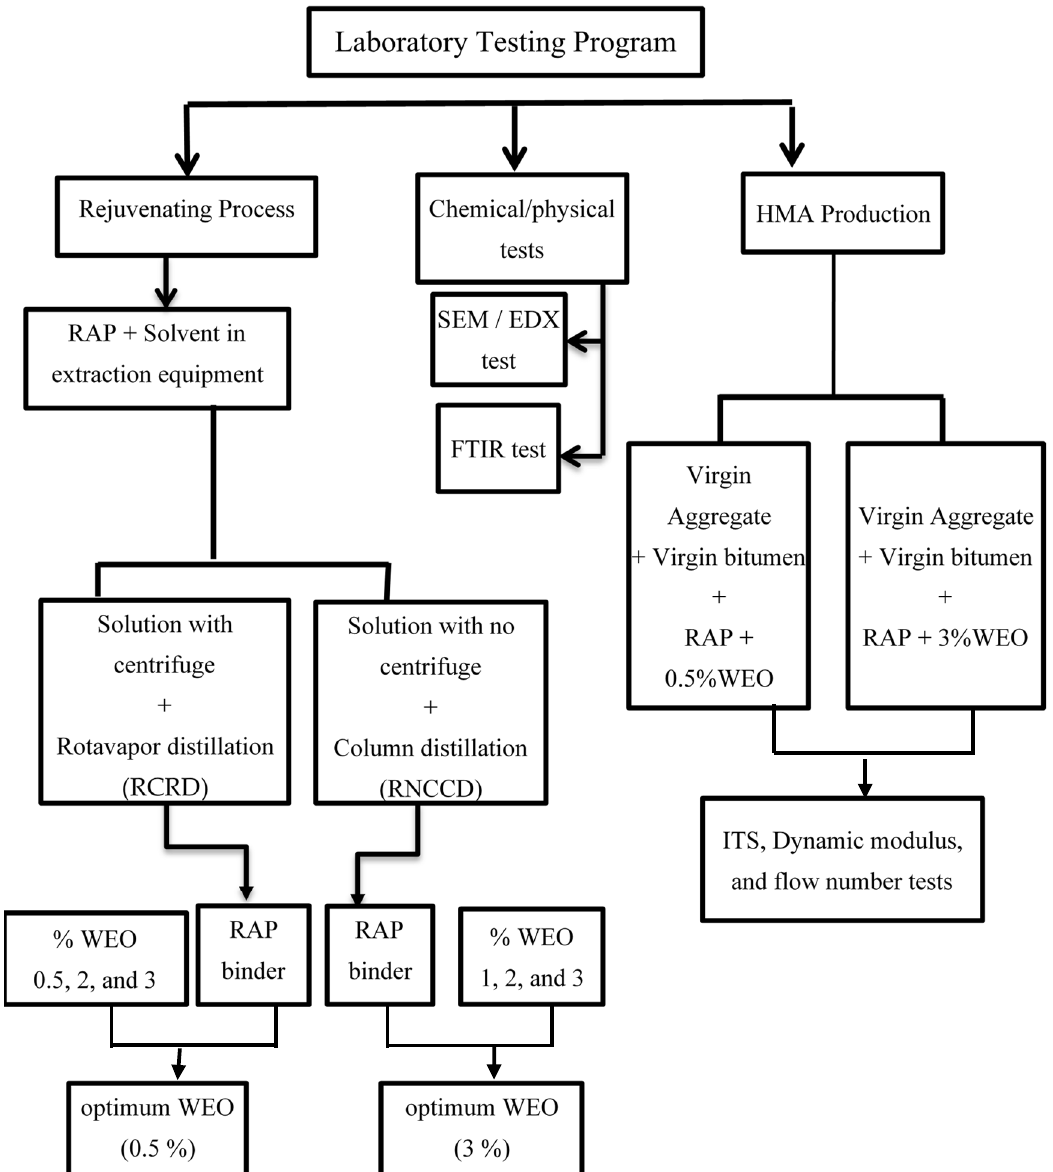
Figure 1. Experimental program flow chart.